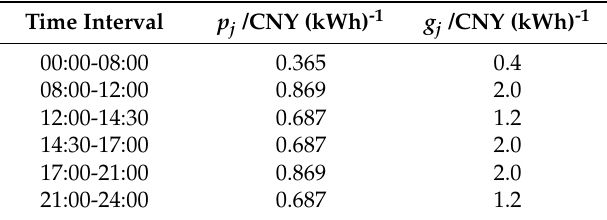
Table 2. TOU price set by grid and